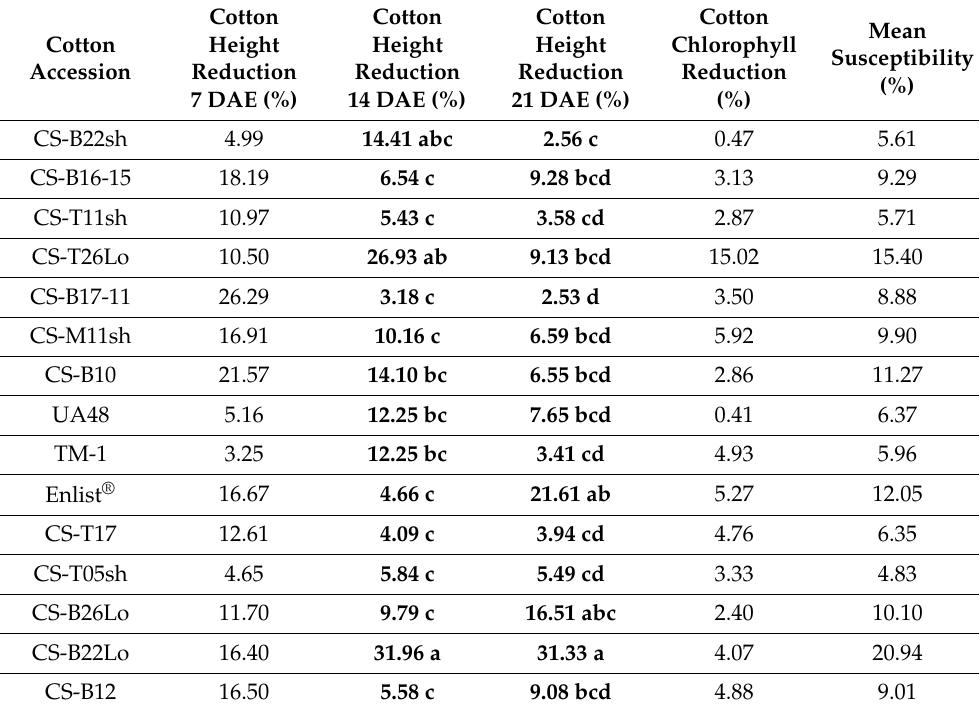
Cotton Mean Chlorophyll Susceptibility Reduction (%) (%)